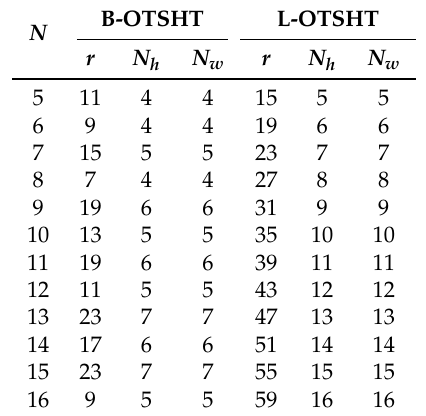
Table 1. The number of rectangles, r , with different sizes having different height, N h , and different width, N w , in the set of OTSHT of size N × N .